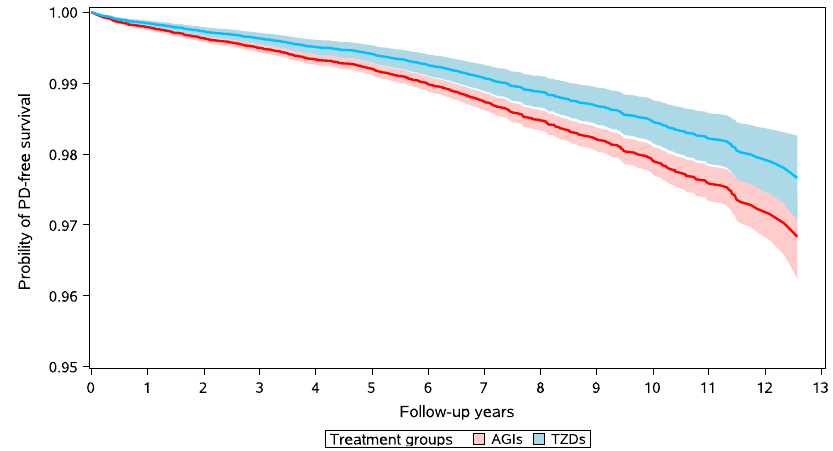
Fig. 2 IPTW-weighted survival curves of TZD users and AGI users. AGIs alpha glucosidase inhibitors, TZDs